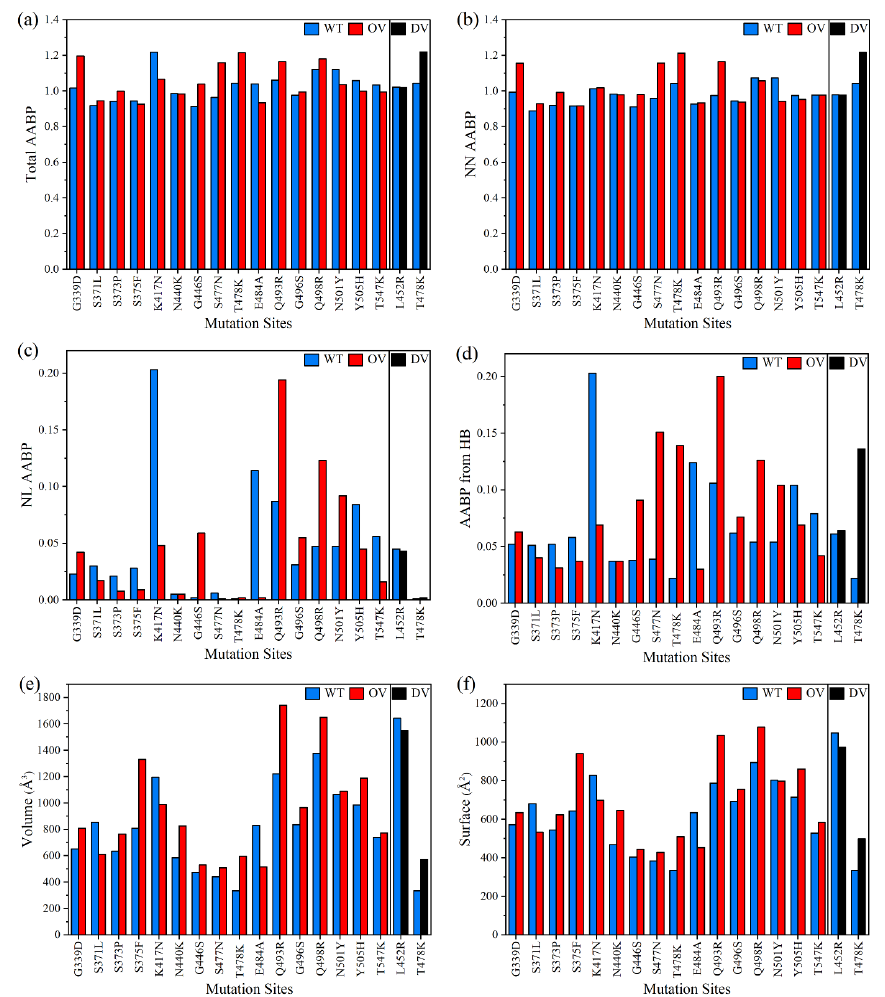
Figure 3. Comparison of 2 DV and 16 OV mutations with their corresponding WT sites in the RBD– SD1 model (from reference [31]) in terms of: ( a ) Total AABP; ( b ) NN AABP; ( c ) NL AABP; ( d ) AABP from HB; ( e ) Volume; and ( f ) Surface area.